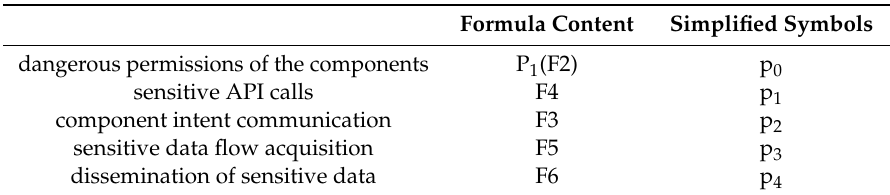
Table 2. Symbol simplification of Equation